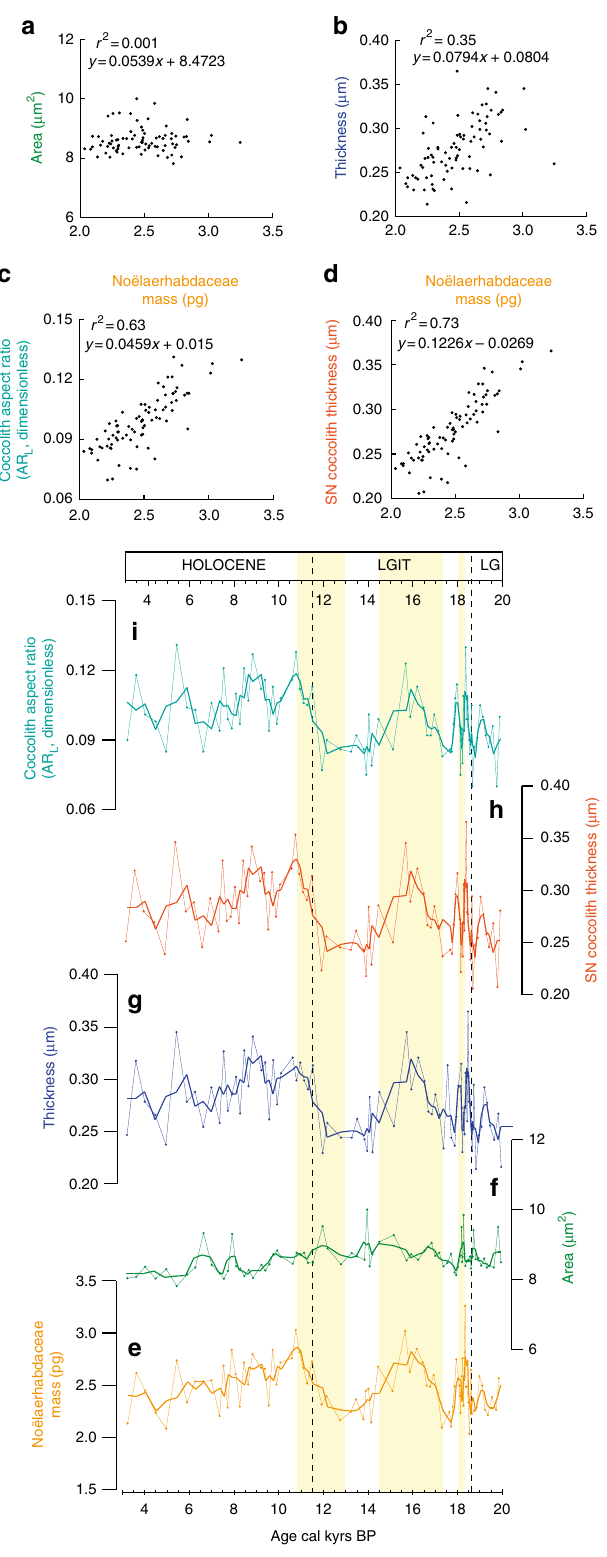
Fig. 3 Noëlaerhabdaceae coccolith morphometrics, and their response to excepted [CO 2aq ] at site MD07-3088 over the last deglaciation. a – d Relationships between coccolith mass (pg) and coccolith area ( a ), thickness ( b ), as well as coccolith aspect ratio (AR L ) 28 ( c ) and SN thickness 27 ( d ) (Methods section). e – i Coccolith morphometric changes during the deglaciation: e mass (pg), f area ( μ m 2 ), g thickness ( µ m), h – i SN 27 and AR L 28 indices (Methods section). Coccolith mass show no relationship with coccolith area, but clear positive relationships with size mass of coccoliths typically increases in proportion with their